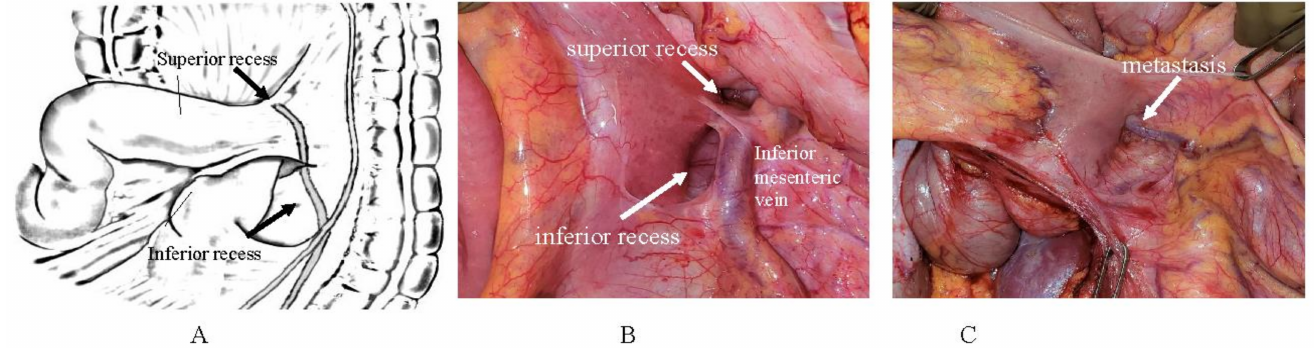
Figure 27. ( A , B ) Duodenojejunal junction has two pockets, i.e., the superior recess and inferior recess. ( A , B ) Duodenojejunal junction has two pockets, i.e., the superior recess, and inferior recess. ( C ) Metastasis on the inferior recess.